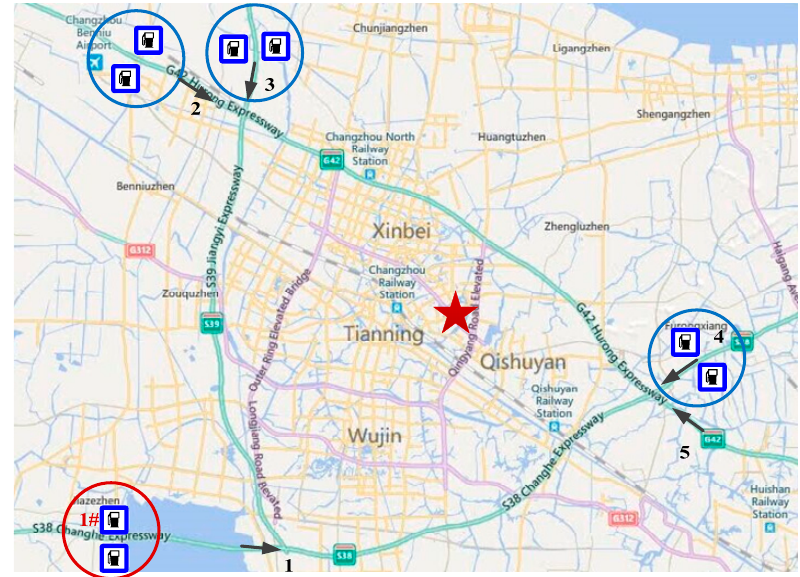
Figure 5. Primary roads in the region of Changzhou,